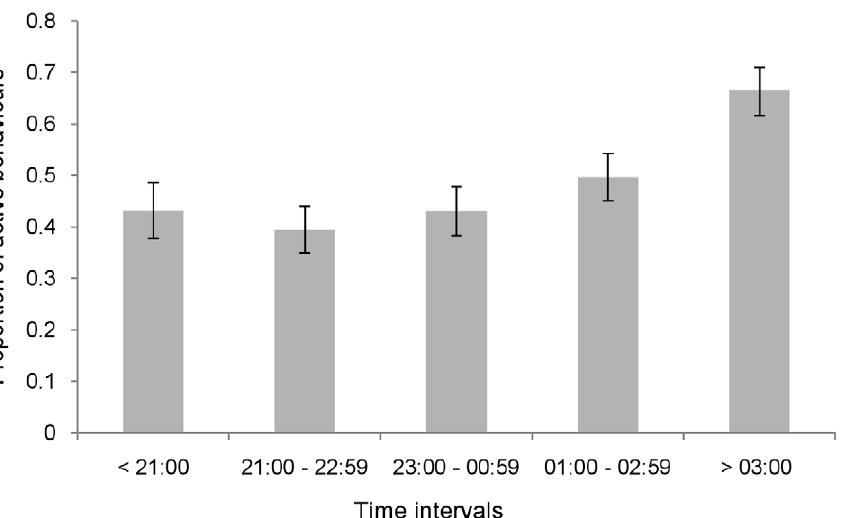
Figure 2. Proportion of active behaviours across the night excluding periods of astronomical twilight. The standard error of the logit values were used to construct 95% confidence intervals indicated by the error bar. Means are adjusted for other fixed effects.